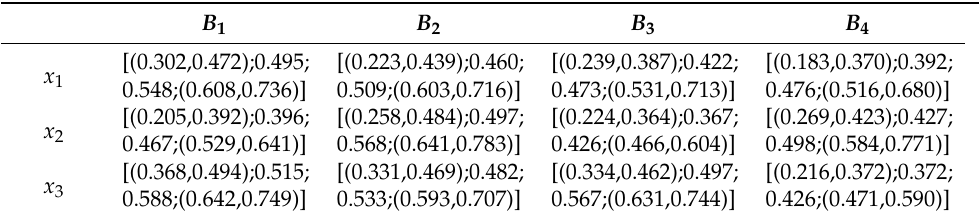
Table A23. The integrated evaluation value of different parameters belonging to open-pit slope risk.